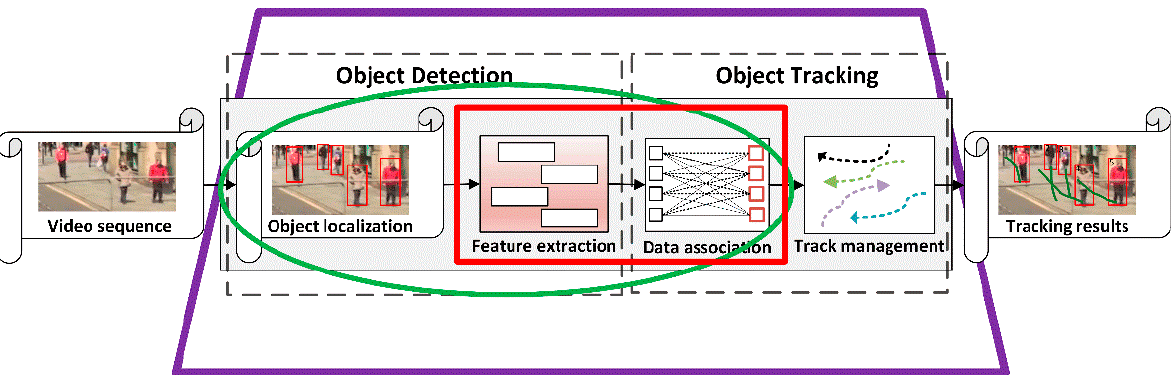
Figure 5. Three Algorithmic Frameworks of JDT. Three different JDT algorithms are created by fusing the sub-modules encompassed by the purple trapezoidal curve, green elliptic curve, and red rectangular curve. (Source: This image is from the MOT16 dataset [25] ).